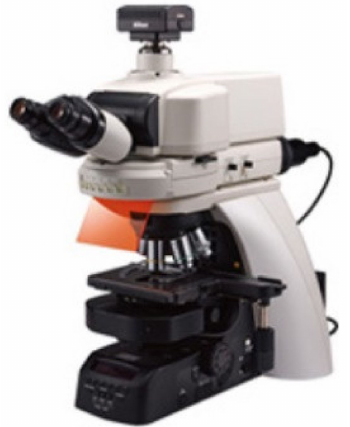
Figure 2. The commercial fluorescence microscopy imaging